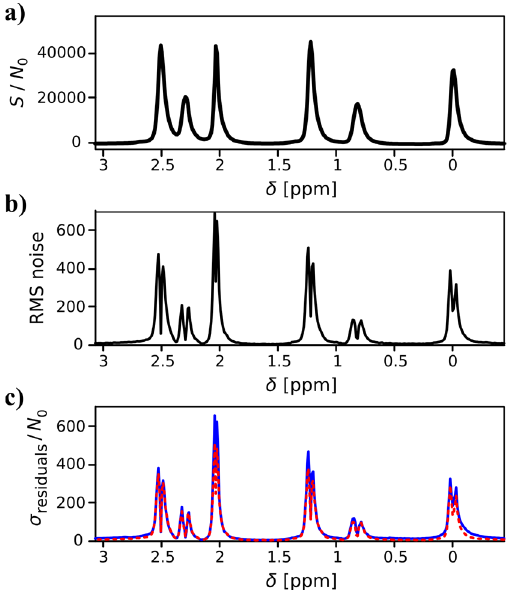
Figure 3. Illustration of multiplicative noise in 1 H NMR T 2,app data of neat [Pyr 13 ][Tf 2 N]. ( a ) 1 H NMR spectrum of first echo. The signal intensity is normalized to the noise standard deviation N 0 in the absence of any signal. Notice the very high signal-to-noise ratio, which is a prerequisite for the observation of multiplicative noise. ( b ) Estimation of root-mean-square (RMS) noise level of the above spectrum. The shape is characteristic for multiplicative phase noise, with a maximum at positions with maximum first derivative of the signal [75]. ( c ) Standard deviation of the residuals of the ILT fit (blue) and estimation of the standard deviation based on the assumption of multiplicative phase noise, as depicted in ( b ) (red dashed).